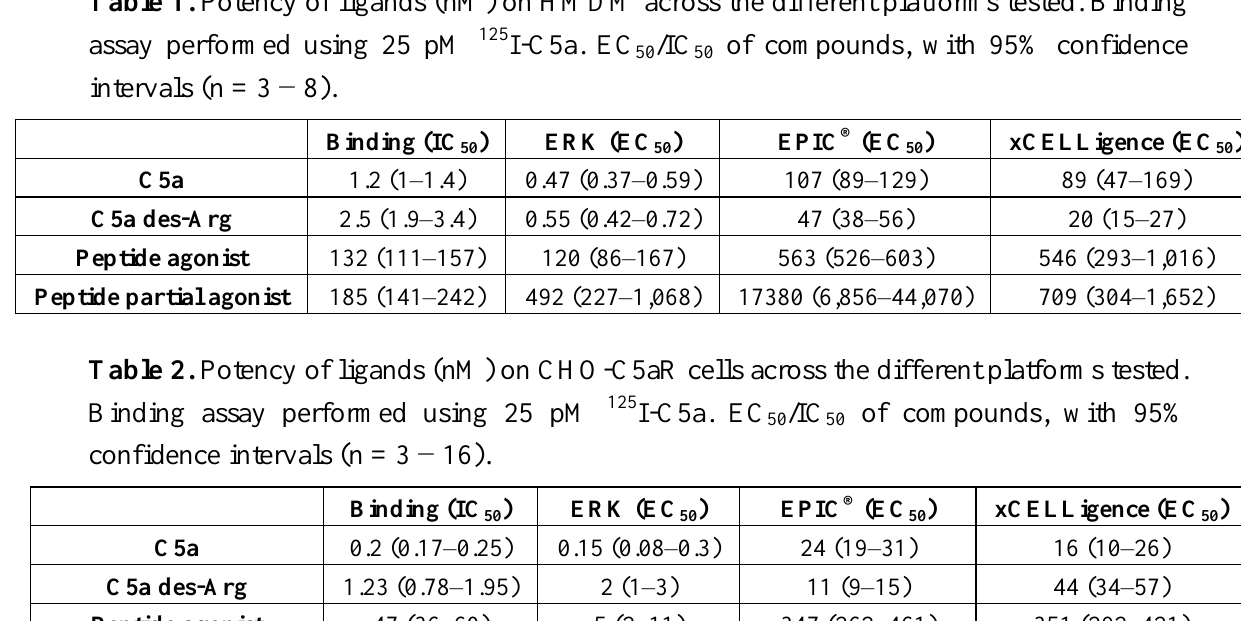
/IC of compounds, with 95% confidence 50 50